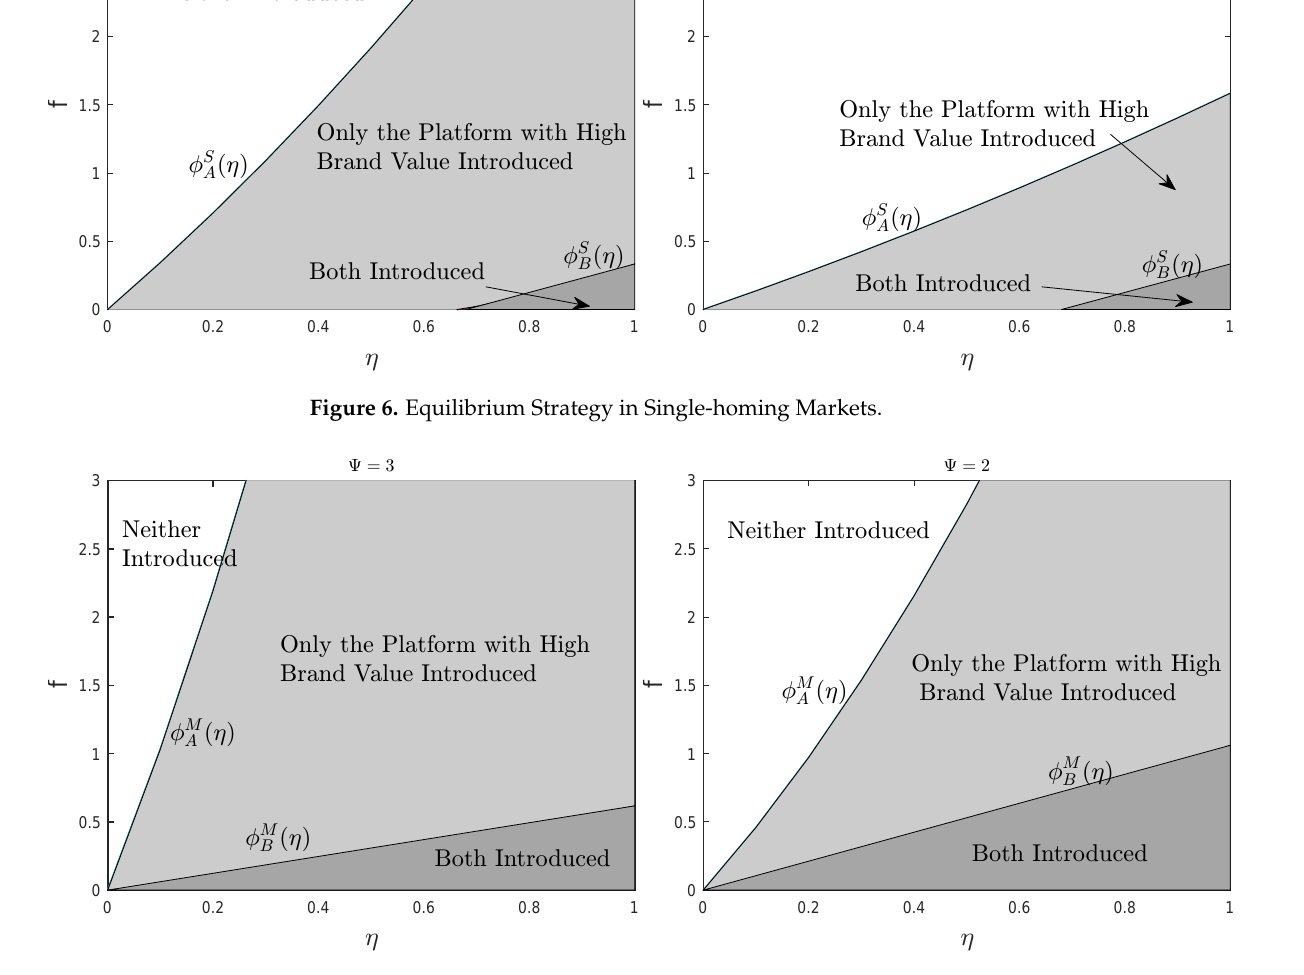
Figure 7. Equilibrium Strategy in Multi-homing